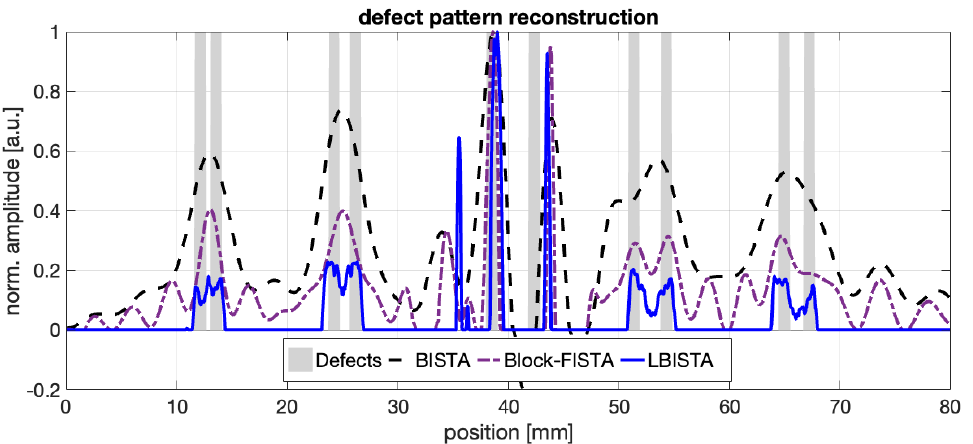
Figure 5. Pattern reconstruction of blackened stripes as shown in Figure 4 using BISTA, Block-FISTA, and tied LBISTA. For LBISTA the parameters in Table 1 were used. Hence, synthetic training data have been used. The BISTA and Block-FISTA result has been created by using γ = 1 √ N iter = 500 (selected from [30]). The marker line can be seen in the BISTA curve exhibiting normalized amplitude values < 0 at position